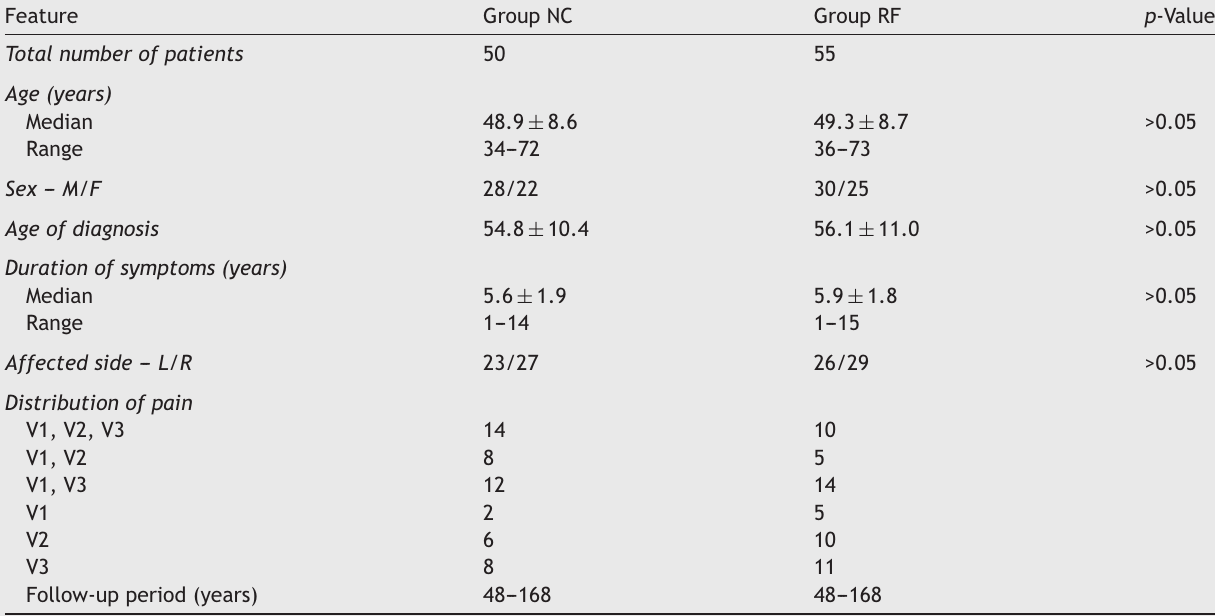
Demographic and clinical information in the 50 patients of group NC and 55 patients of group RF.